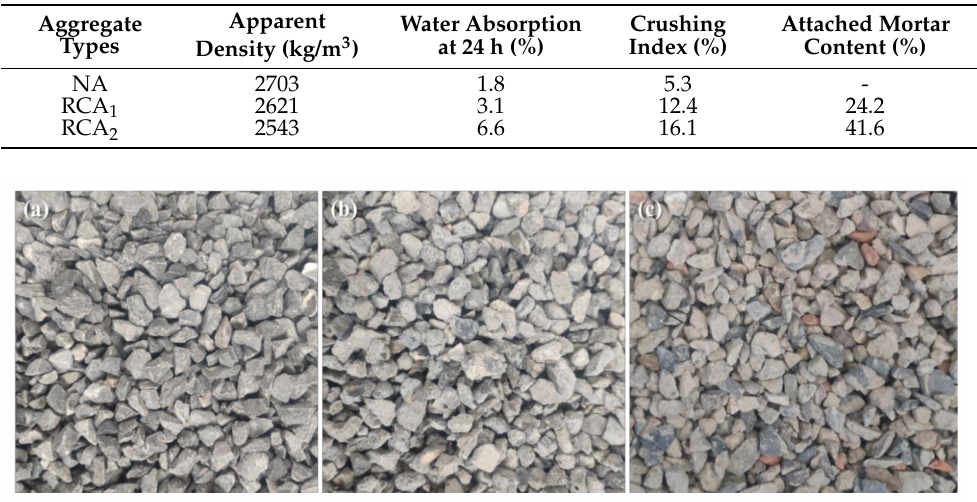
Figure 1. Macro photographs of three types of aggregate: ( a ) NA; ( b ) RCA 1 ; and ( c ) RCA 2